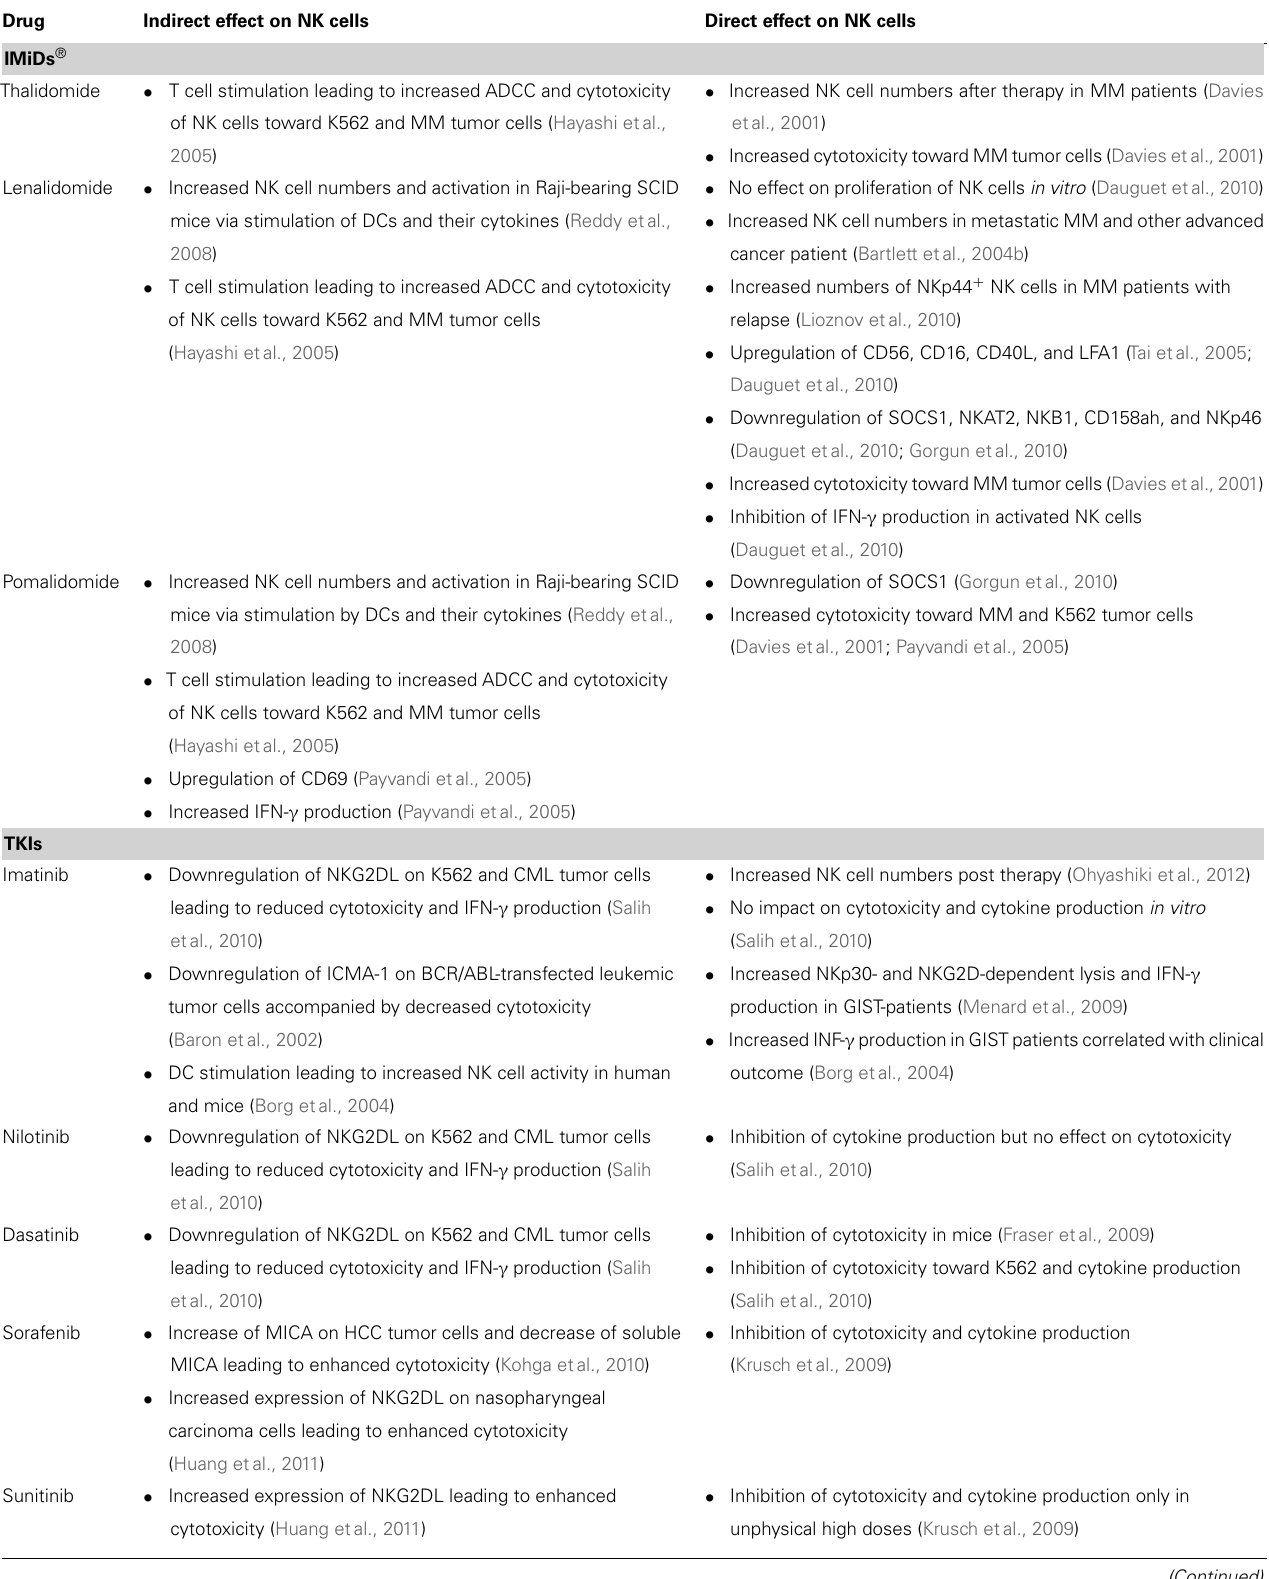
Table 1 | Overview on the impact of immunomodulating agents on NK cells.